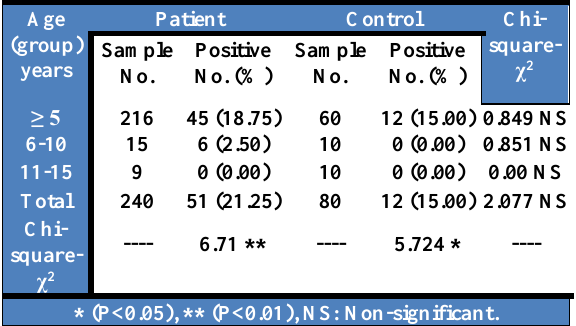
Figure, 1: ELISA test .Pc, positive control .NC, negative control. NP, negative patient. PP, positive patient. Table, 1: Distribution of toxin A and/or B according to age groups human samples.